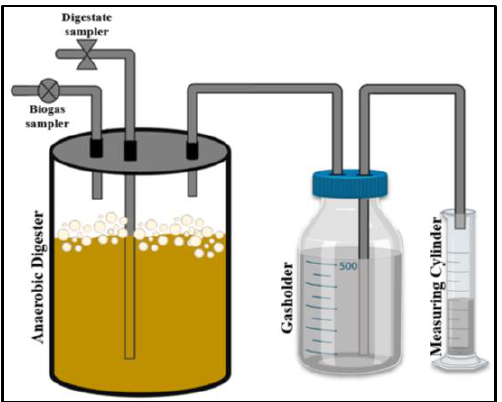
Figure 1. Representation of the bench-scale improvised digesters, which were used for anaerobic digestion of SMS hydrolysate. digestion of SMS